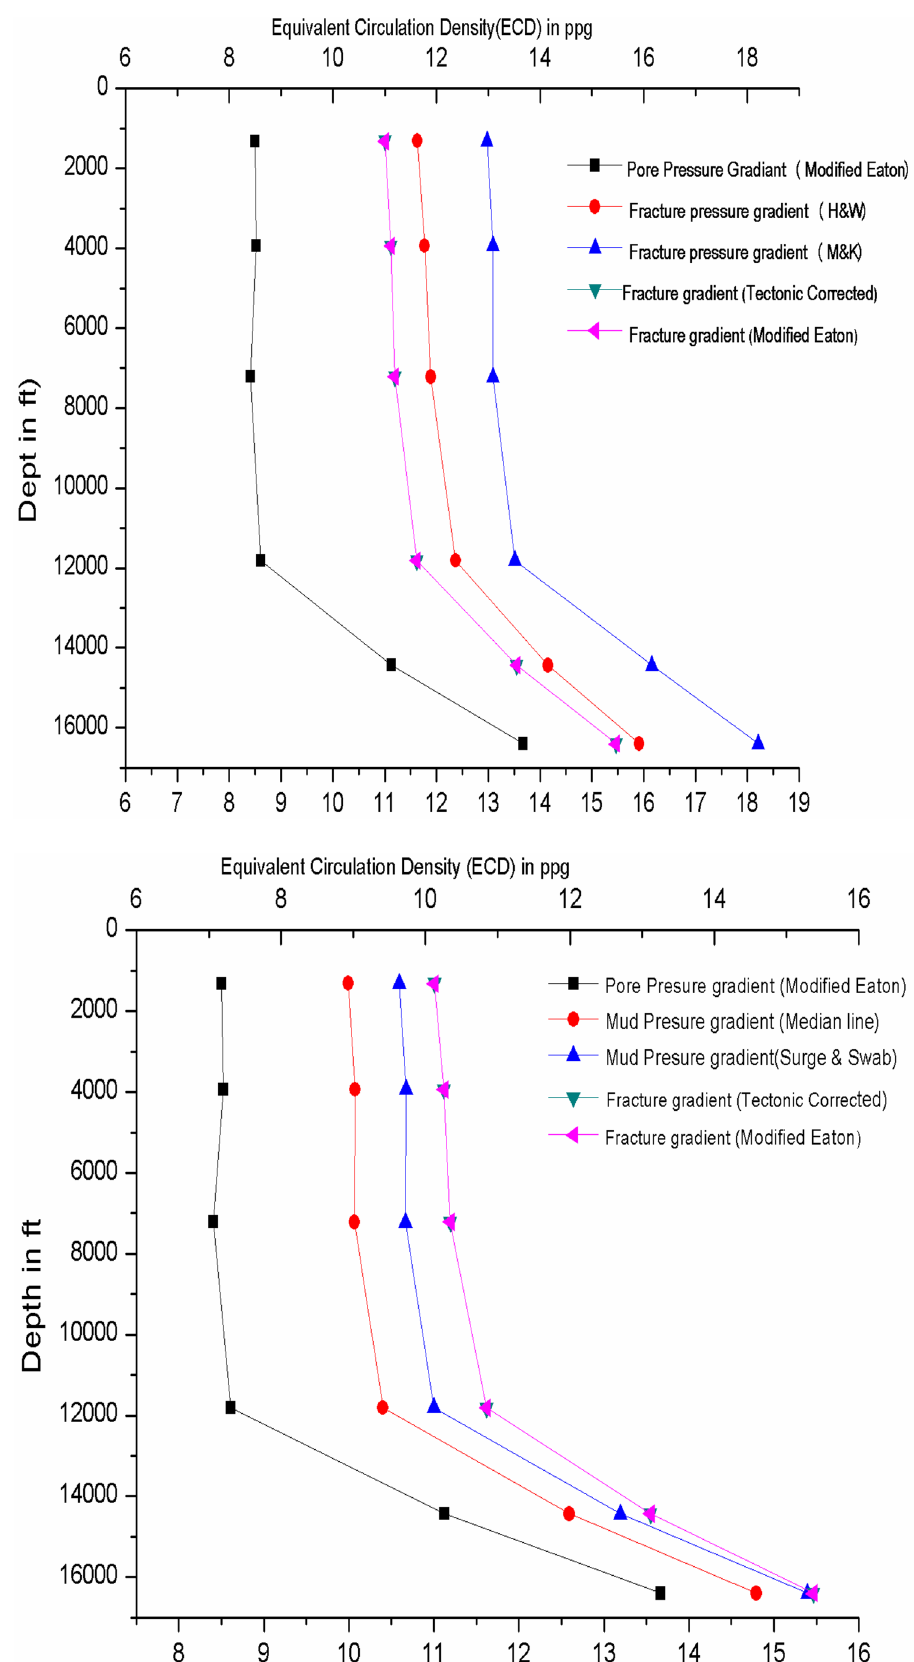
Fig. 8 Drilling mud window on